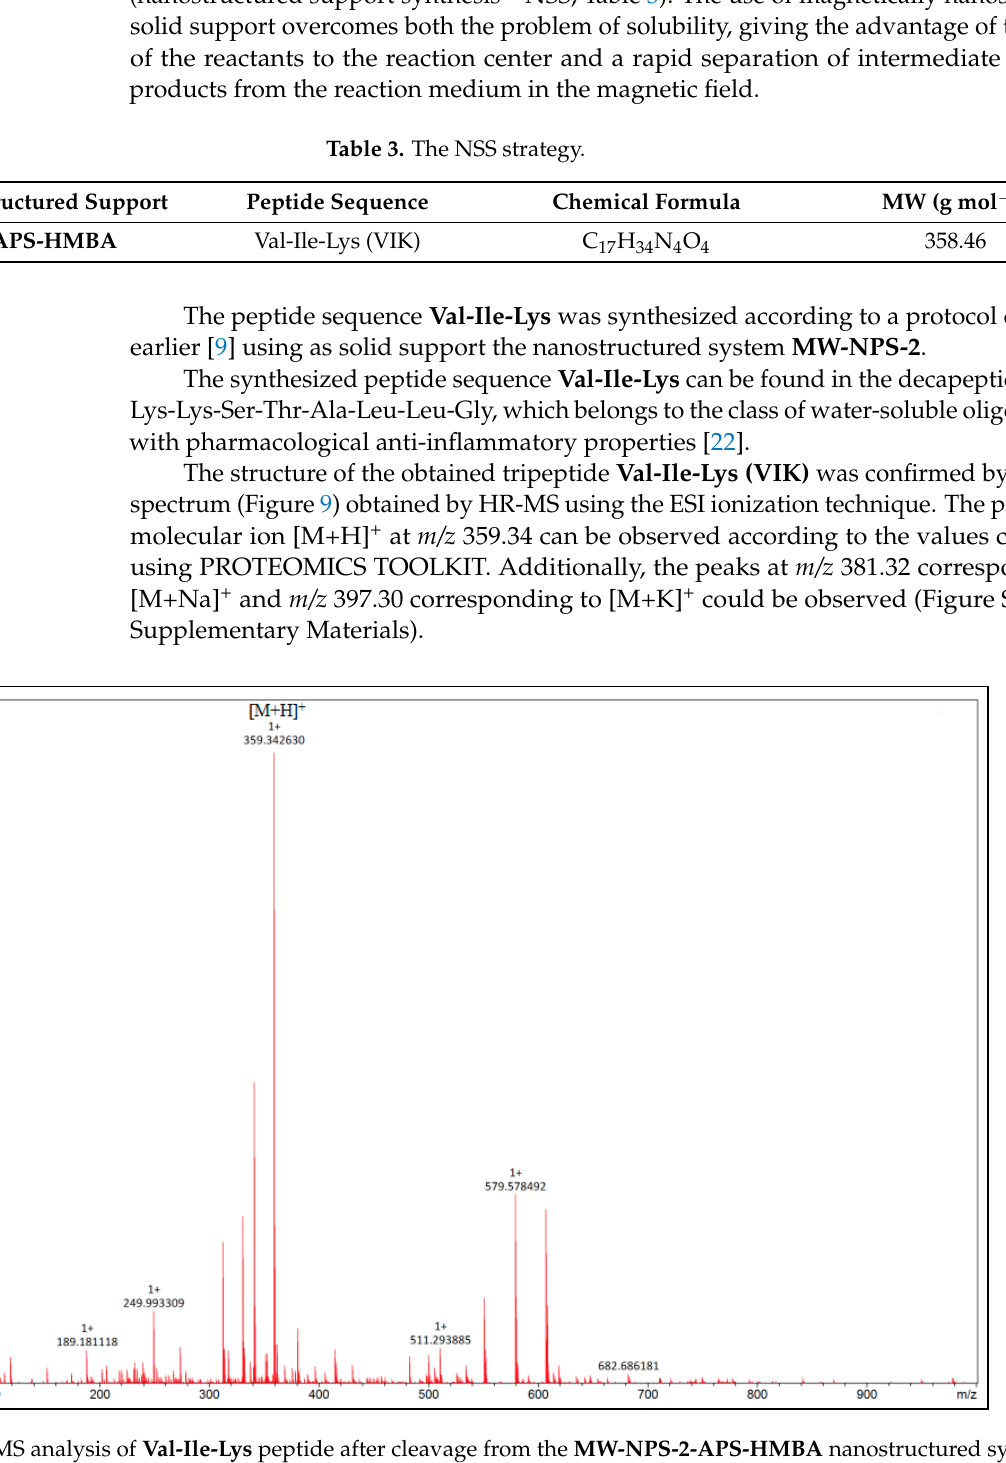
Figure 10. Theoretical fragmentation of the Val-Ile-Lys peptide.